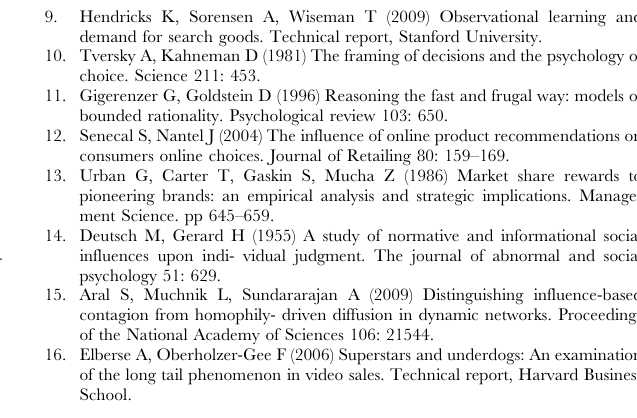
(TIFF) Figure S2 The conditional probability of downloading a song (given it was sampled) does not depend on the total number of songs a participant samples. Figure S2 shows the average conditional probability of download versus listener type. (TIFF) Figure S3 Listener type on the vertical axis, versus conditional probability of download. (TIFF) Figure S4 Inequality results in each of the 8 worlds of Experiments 1 and 2.